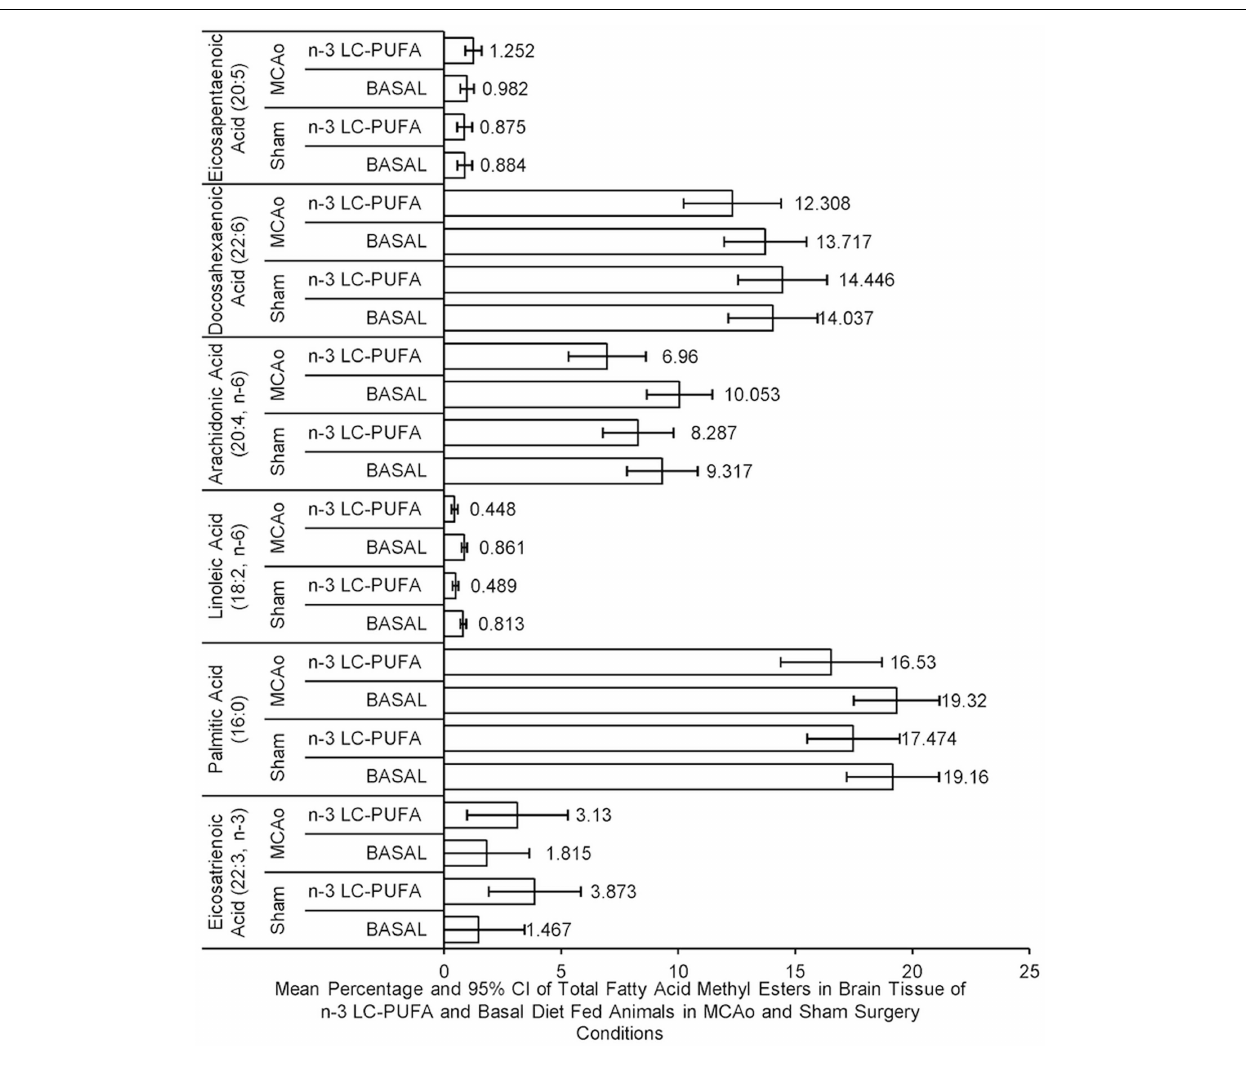
differences are seen in fatty acid methyl esters between surgery groups. − 20:5 n -3, eicosapentaenoic acid; 22:6 n -3, docosahexaenoic acid; 20:4 n -6, arachidonic acid; 18:2 n -6, linoleic acid; 16:0, palmitic acid; 22:3 n -3, eicosatrienoic acid. MCAo, middle cerebral artery occlusion surgery condition; Sham, Sham surgery condition; Basal, basal diet condition; n -3-LC-PUFA, n -3 L-C-PUFA enriched diet condition. *Denotes statistically significant at p = 0.05, **denotes statistically significant at p = 0.01. n = 11 n -3-LC-PUFA MCAo; n = 13 Basal MCAo; n = 12 n -3-LC-PUFA sham; n = 12 Basal